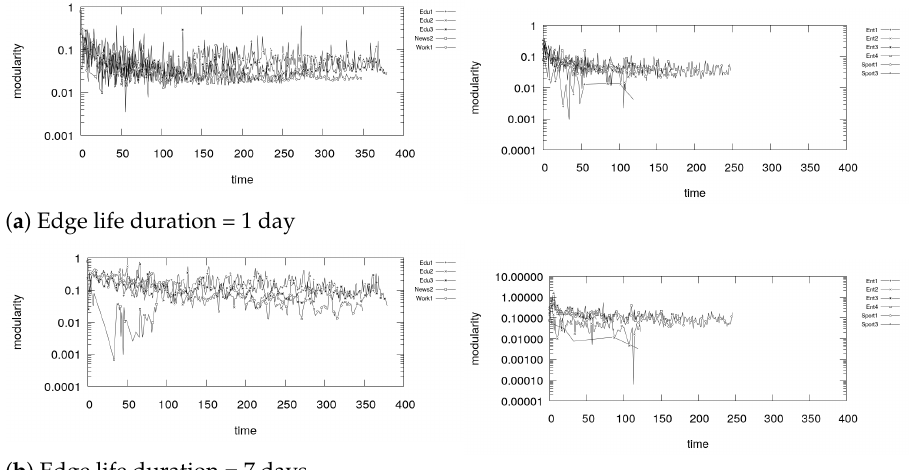
Figure 25. Modularity of communities detected by